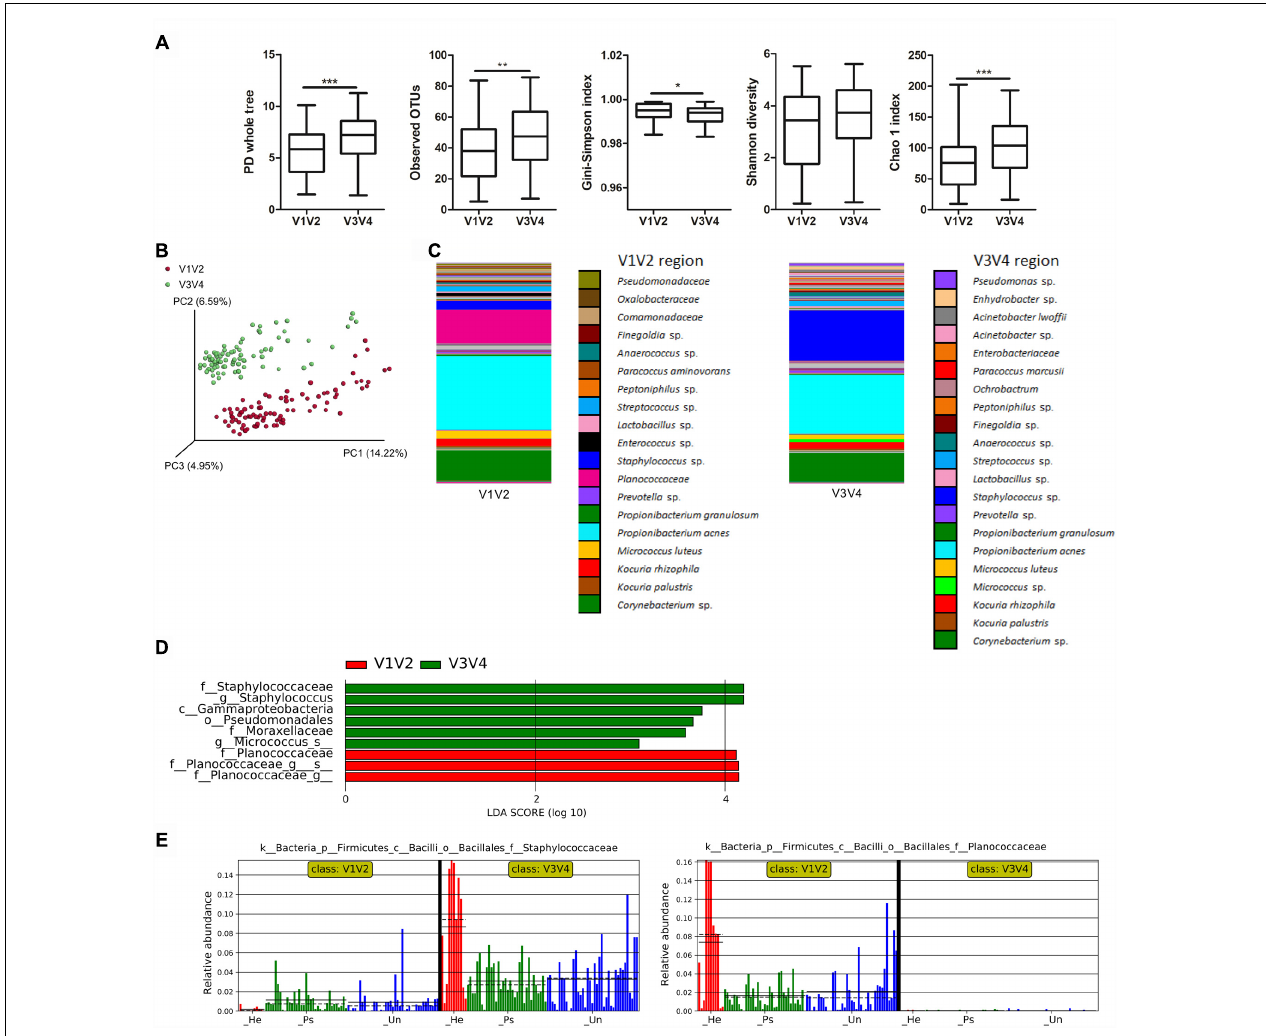
FIGURE 1 | Differences in microbiota composition due to sequencing of different 16S rRNA regions. (A) Alpha diversity metrics for V1V2 and V3V4 regions are shown using PD whole tree, OTU richness, Gini-Simpson index, Shannon diversity index, and Chao1 index. (B) PCoA of Unweighted UniFrac distances (beta diversity) between the respective regions. Statistical significance was confirmed using PERMANOVA; p ≤ 0.001 Red: V1V2, Green: V3V4. (C) Relative abundances of major taxonomic groups in V1V2 and V3V4 regions. (D) LEfSe analysis describing the significant differences in genera between V1V2 (red) and V3V4 (green) regions. (E) Histogram of the Staphylococcaceae and Planococcaceae relative abundances in V1V2 and V3V4 regions. Disease status (Ps, psoriatic; Un, unaffected; He, healthy skin) is color-coded and the mean (solid line) and median (dashed line) are marked. ∗ p < 0.05; ∗∗ p < 0.01, and ∗∗∗ p <